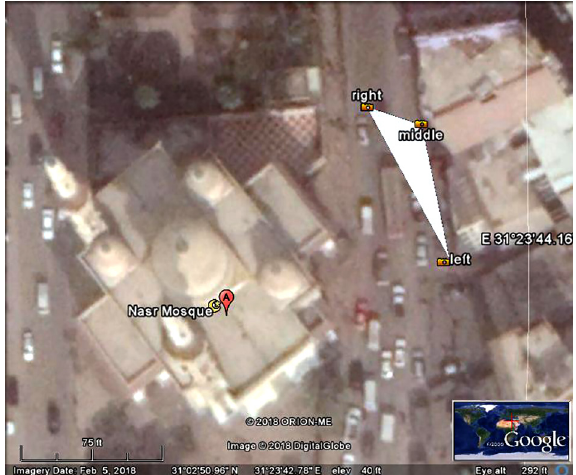
Figure 2. El-Nasr Mosque site from Google Earth image and the occupied positions of photos